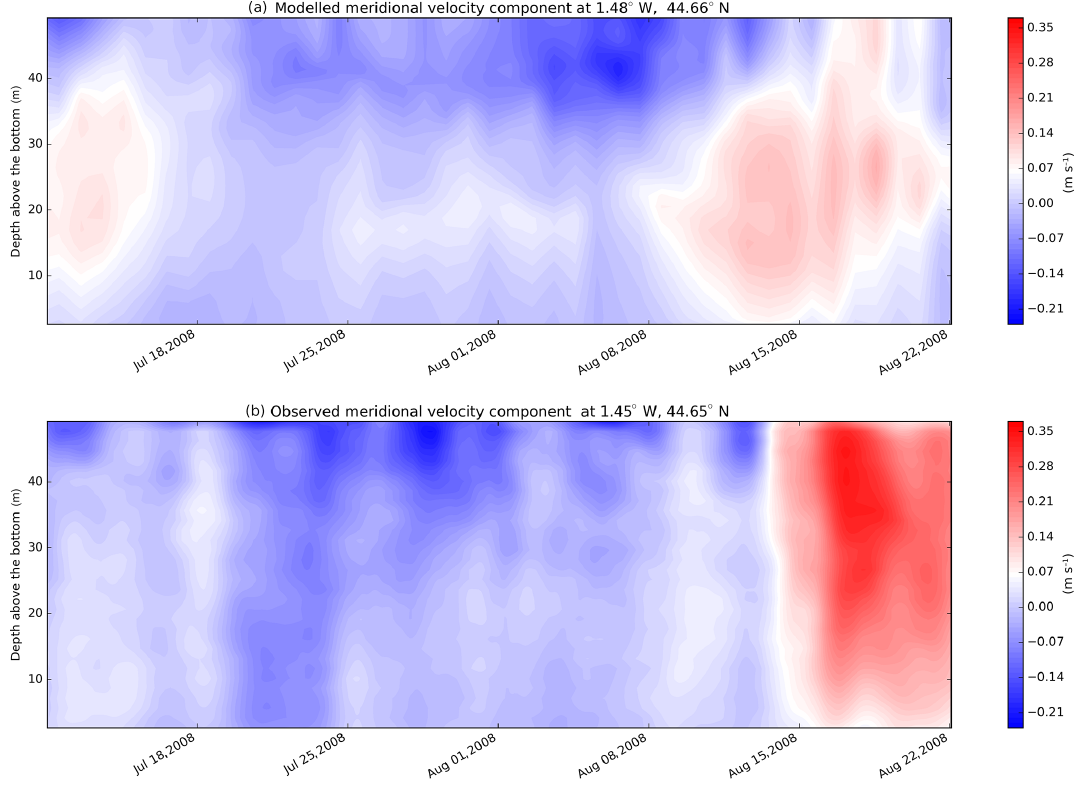
Figure 8. Evolution of meridional velocity component inms − 1 of the BACH1000_100lev model during July–August 2008 (a) at the AR- CADINO ADCP location. ADCP observations for the same periods are represented (b)